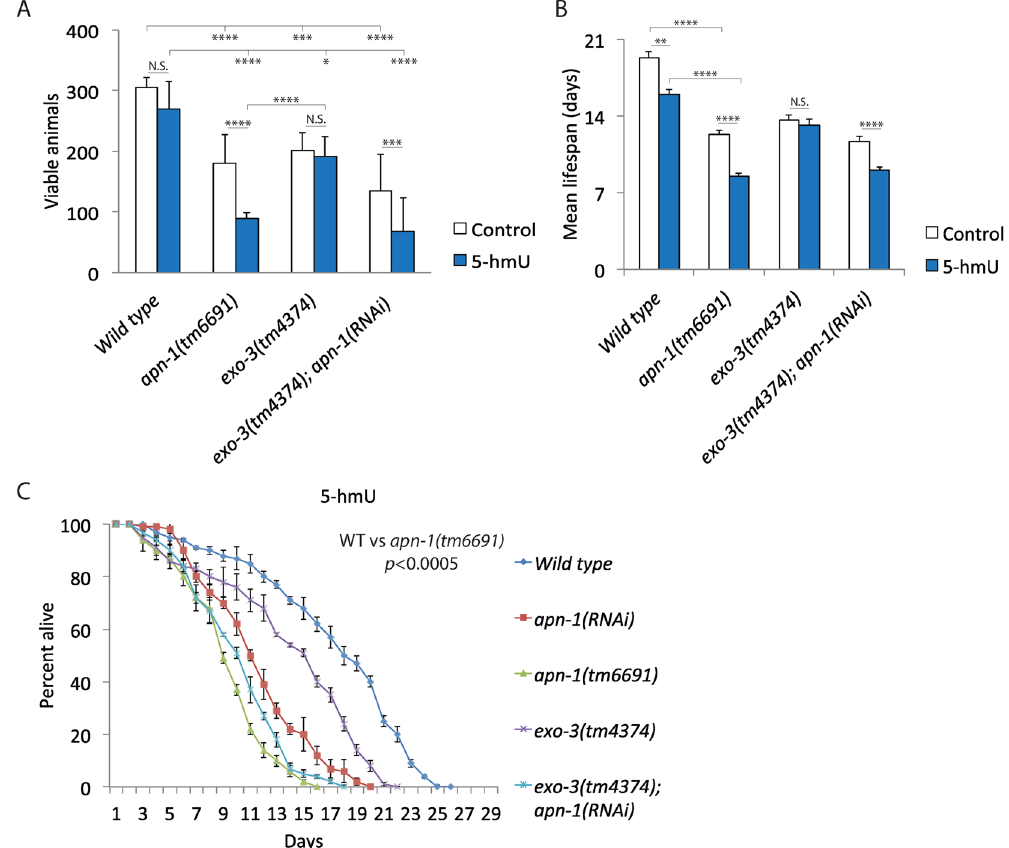
Figure 2. C. elegans apn-1 , but not exo-3 , mutants are sensitive to the nucleoside 5-hmU. ( A ) Brood size analysis of animals exposed to 5-hmU. Wild type: 269.8 ± 46; apn-1(tm6691) : 102 ± 21; exo-3(tm4374) : 171 ± 43; exo-3(tm4374); apn1(RNAi) : 68 ± 55. Control; Wild type: 305 ± 17; apn-1(tm6691) : 181 ± 47; exo- 3(tm4374) : 201 ± 29; exo-3(tm4374); apn1(RNAi) : 134 ± 61. Error bars represent the S.D. Unpaired two-tail t-test *** P < 0.01; **** P < 0.0005 were considered to be statistically significant. N.S. = Non-Significant. ( B ) Mean lifespan of the indicated animals exposed to 5-hmU. ( C ) Kaplan-Meier survival plot showing the percentage of alive animals when the indicated genotypes were exposed to 5-hmU. L1-staged animals ( n = 100) were exposed to 5-hmU (1 μ M) and lifespan was blindly analyzed starting from young adult worms. The mean lifespan of two independent experiments is